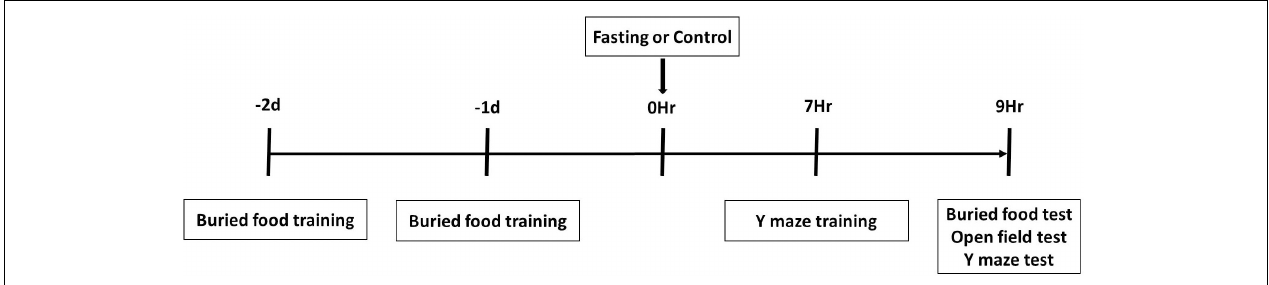
FIGURE 1 | Schematic diagram of experimental design. The mice receive buried food training at 2 days and 1 day before treatment (fasting or control) and Y maze training at 7 h after treatment, and then behavior tests in the order of buried food test, open field test and Y maze test at 9 h after